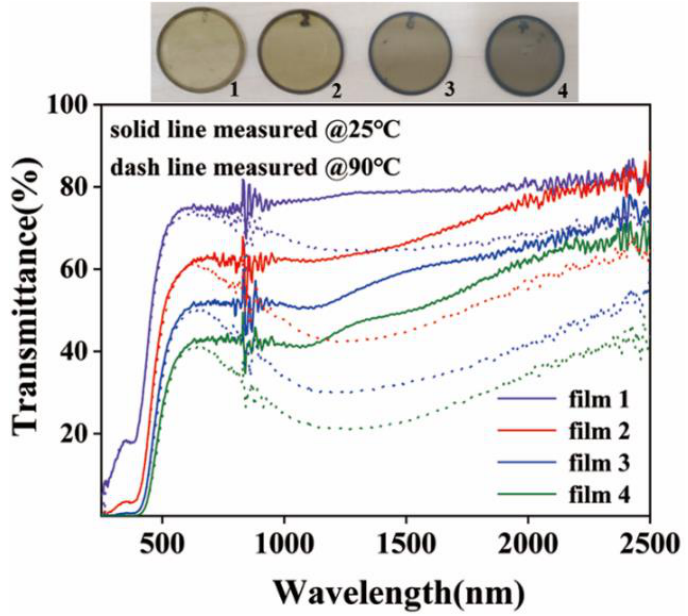
Figure 7. Images and o ptical transmittance of samples with different spin-coating times.